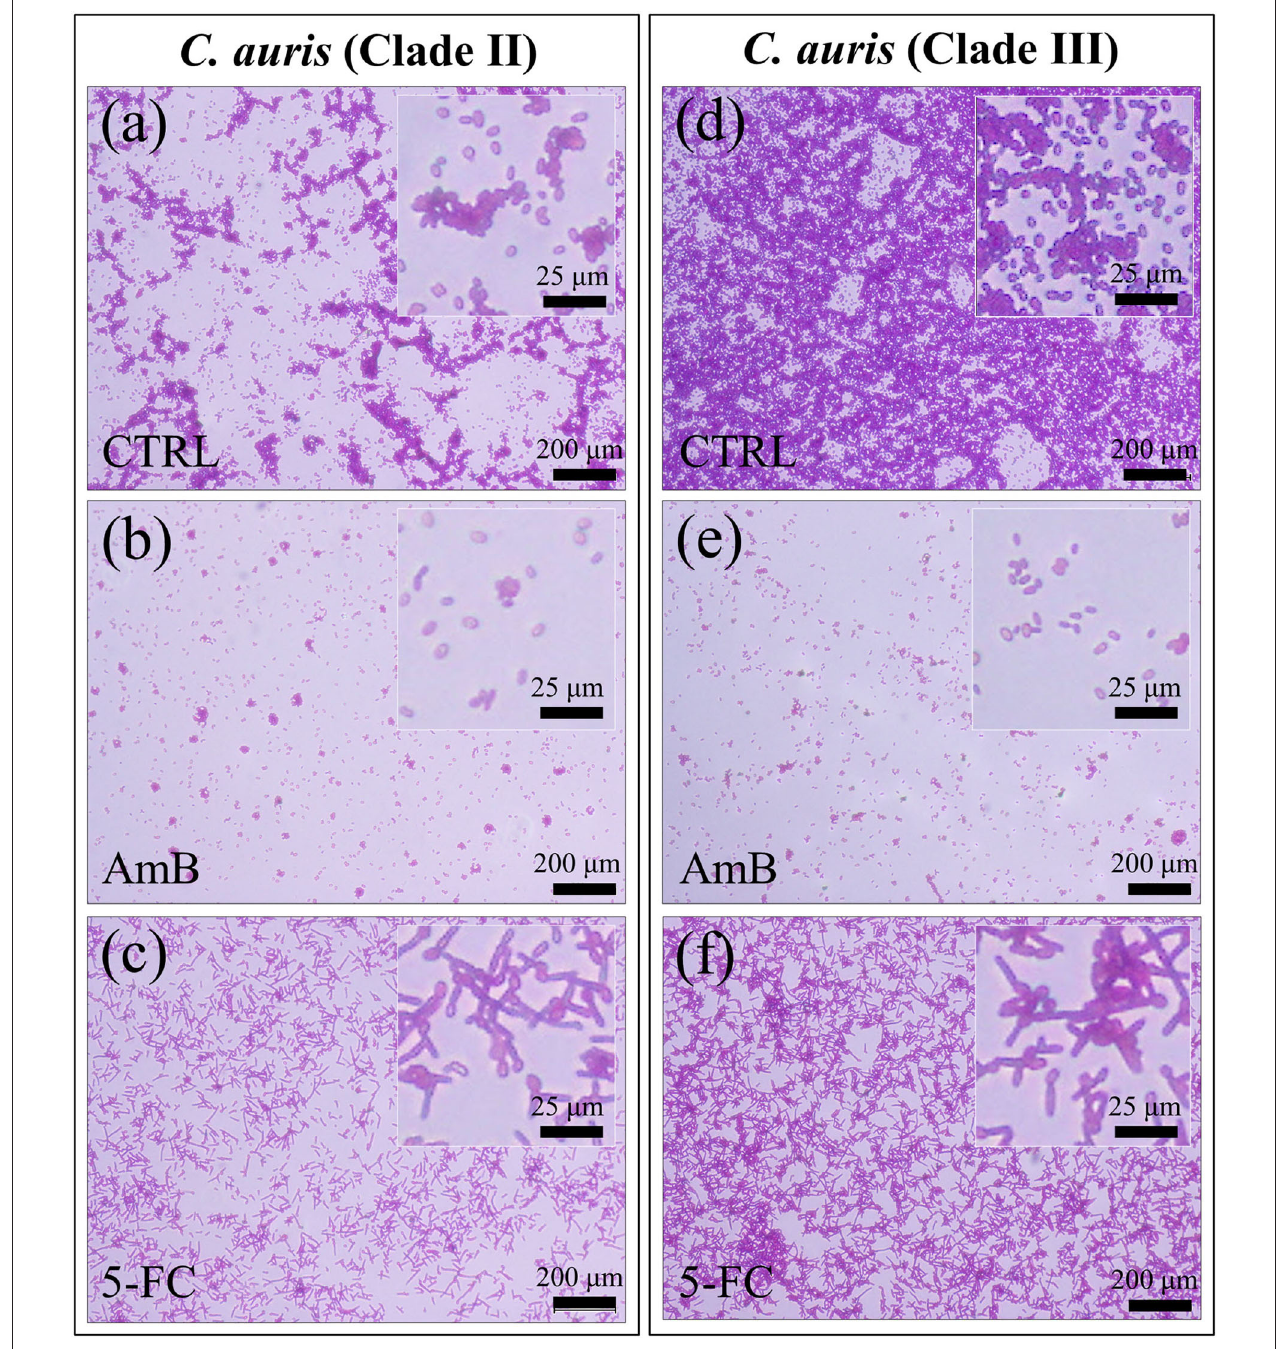
FIGURE 2 | Fluorescence micrographs of violet PAS-stained C. auris cultures before (CTRL label) and after 24h treatment with different drugs (cf. labels in inset): Clade II (a–c) and Clade III (d–f) . The micrographs stain polysaccharides in violet color. Note the most significant reduction in cell density upon AmB treatment [cf. (b,e) ] for Clades II and III, respectively) and the hyphal morphogenesis in the enlarged images in inset to (c,f) . independent of hyphal length (Maza et al., 2017). Raman at the molecular scale the physiological reactions of different